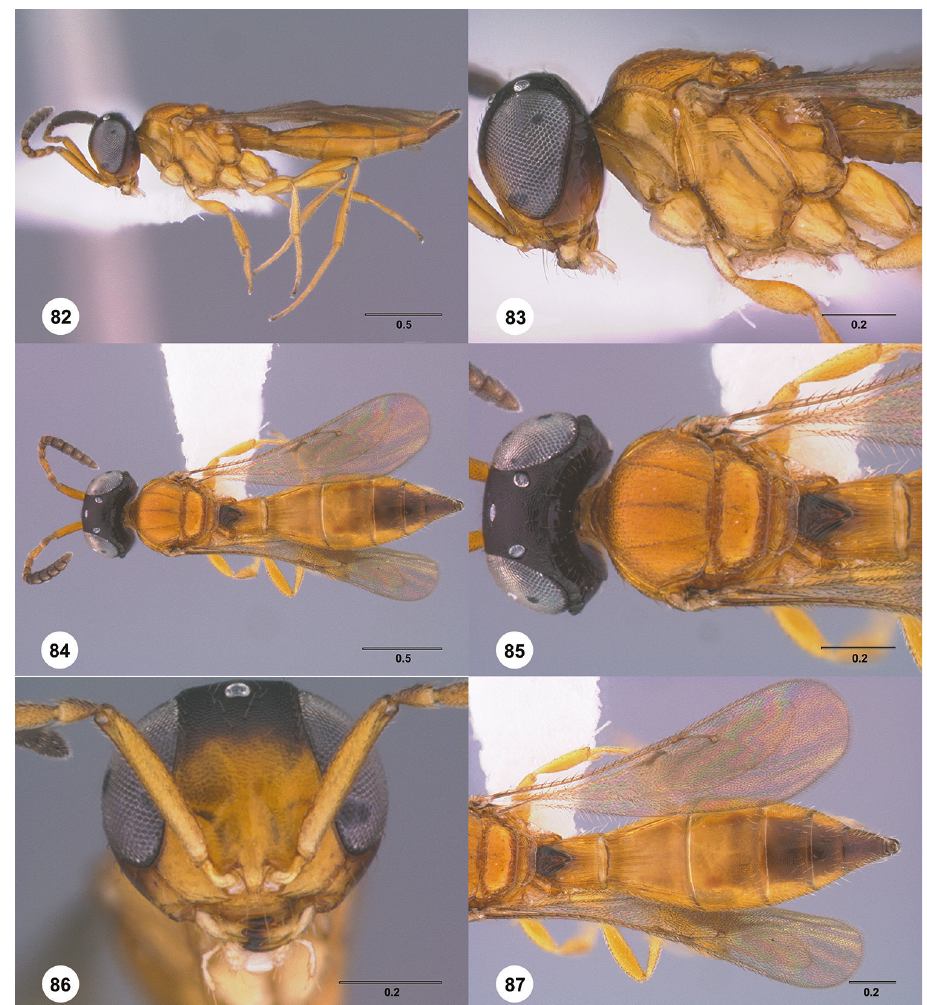
Figures 82–87. Calliscelio crater sp. n., female, holotype (OSUC 276803). 82 Lateral habitus 83 Head and mesosoma, lateral view 84 Dorsal habitus 85 Head and mesosoma, dorsal view 86 Head, anterior view 87 Metasoma, dorsal view. Scale bars in millimeters. flagellomeres: filiform, A11 approximately 2.0× longer than wide. Length of A5 tyloid in male: greater than 0.5× length of A5. Color of mesosoma in female: orange throughout. Color of mesosoma in male: orange throughout; variably orange to pale brown. Sculpture of dorsal pronotal area: rugose. Sculpture of lateral pronotal area: smooth anteriorly, granulate posteriorly. Sculpture of netrion: smooth. Notaulus: percurrent or nearly so. Sculpture of mesos- cutum: granulate. Shape of mesoscutellum: semiellipsoidal. Foveolae of scutoscutellar sulcus between notauli: smaller than those along margin of axilla. Sculpture of